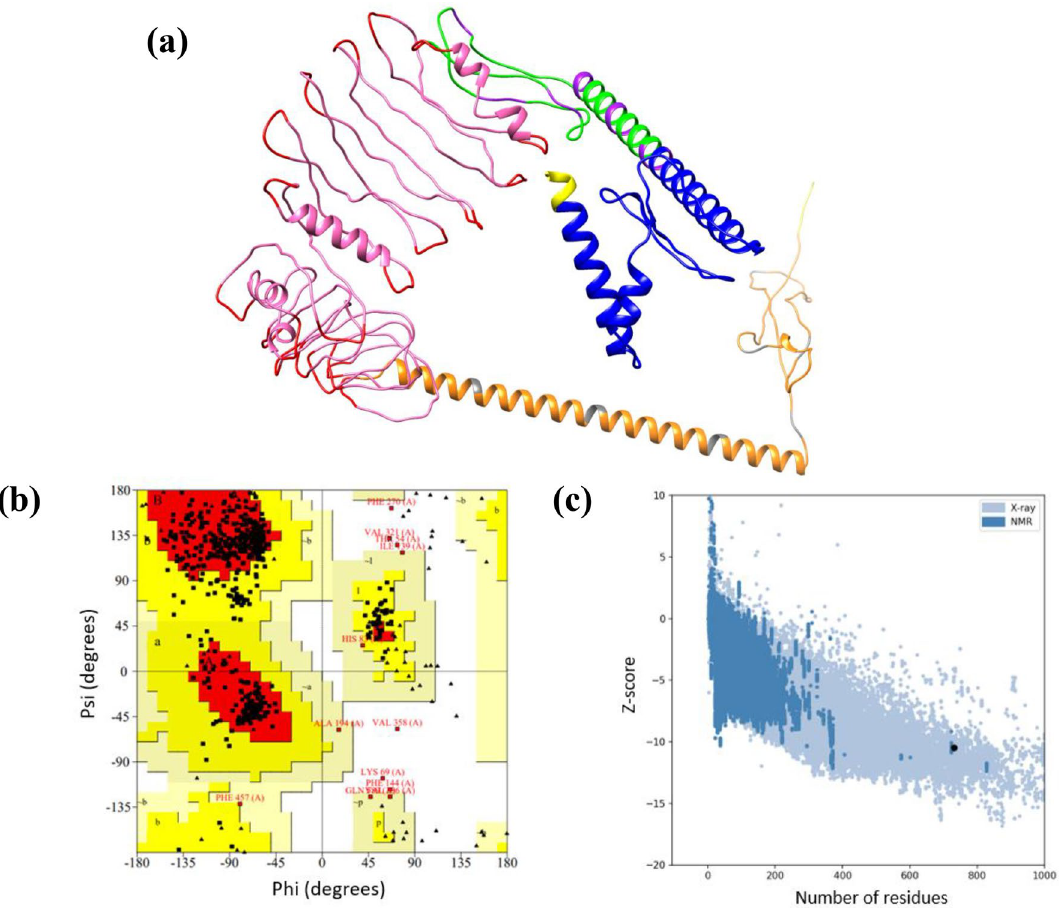
Figure 1. Vaccine construct structural validation analysis ( a ) Refined model of multiepitope vaccine construct (CD8 + T-cell epitopes and AAY linkers-green and purple, CD4 + T-cell epitopes and GPGPG linker—pink and red, B-cell epitopes and KK linkers-orange and gray and the adjuvant—blue) ( b ) Ramachandran plot of refined vaccine (83.2% of the residues of the vaccine are present in the favoured region ( c ) PROSA web score plot indicating a Z-score = − 10.48, indicating overall model